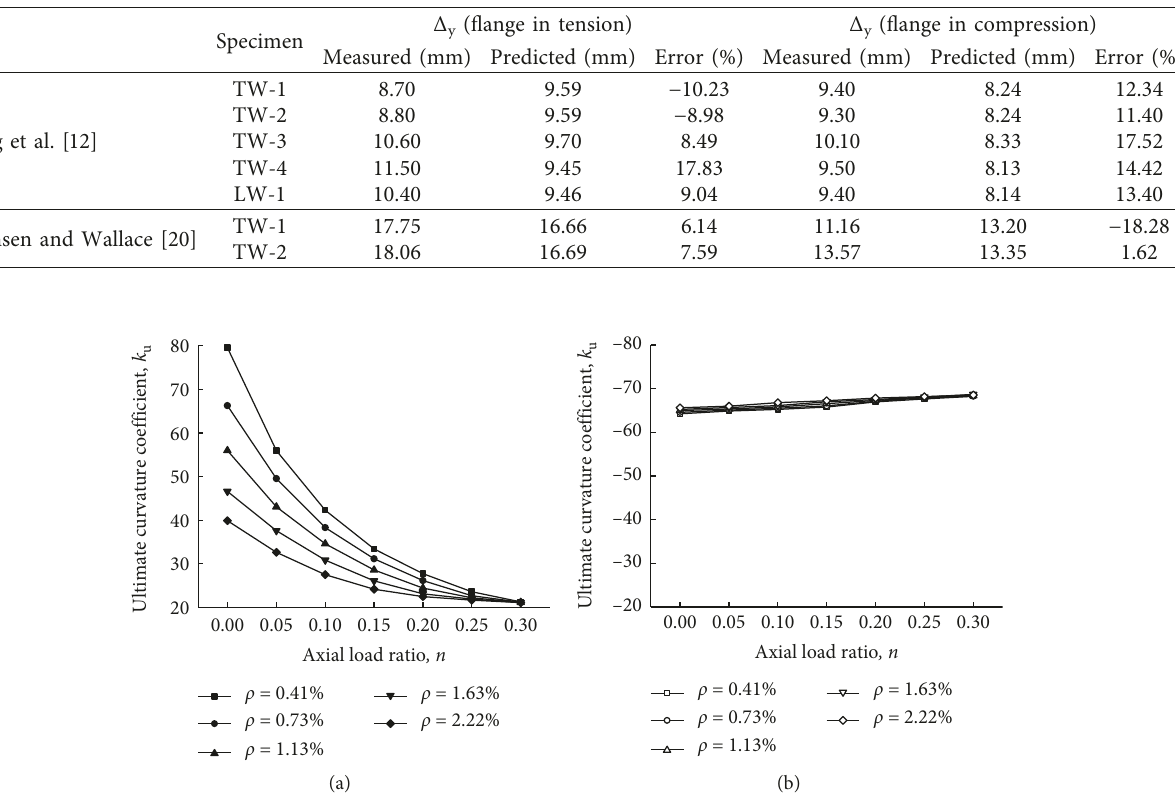
Table 2: Comparison between measured and predicted yield displacements.